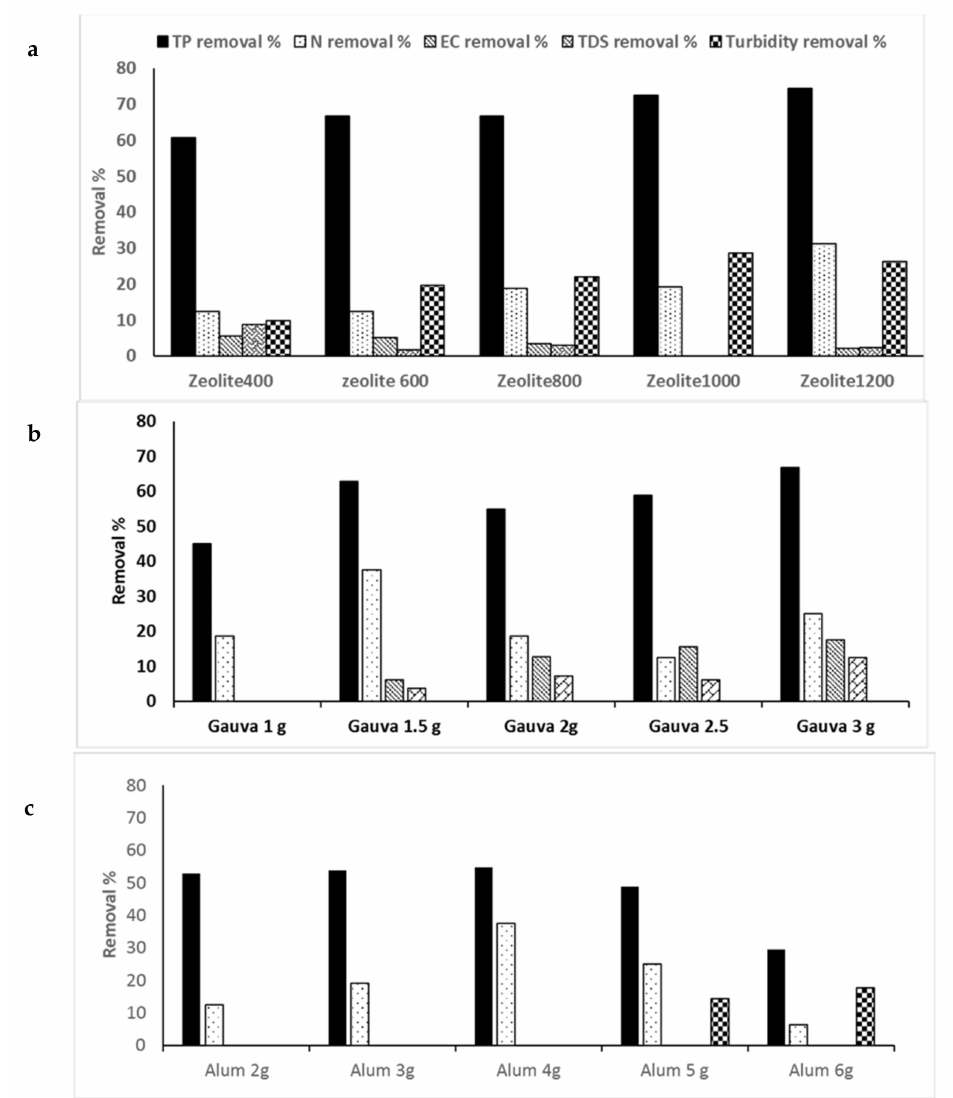
Figure 4. Contaminant removal efficiencies of wastewater by coagulation processes using: ( a ) zeolite, ( b ) guava-leaf powder (GLP), and ( c ) alum. Total phosphorus (TP), Nitrogen Removal (TKN), Electric Conductivity, (EC), and total dissolved solids